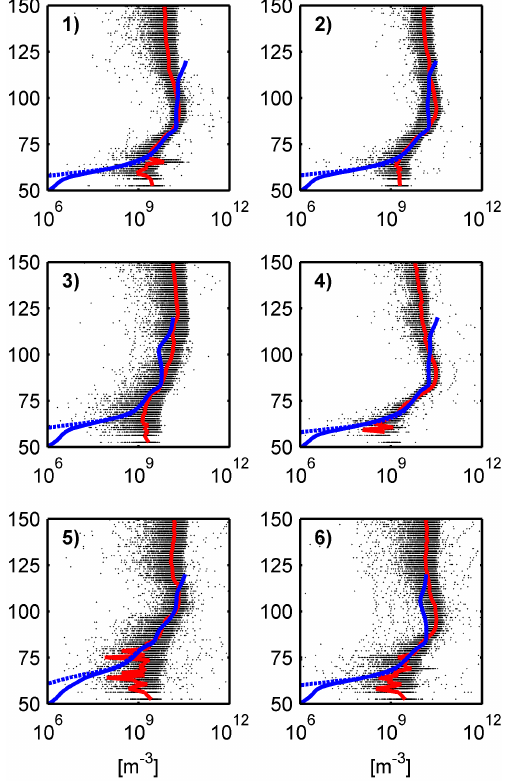
Fig. 2. Detected IS power vs the SIC model for the six cases stud- ied. Red line: mean value of the IS power estimates (black dots) corresponding to heater off-periods. Blue lines: SIC modelled elec- tron density (continuous) and theoretical IS power (Eq. 2) based on the SIC modelled N e , λ and m i (dashed).